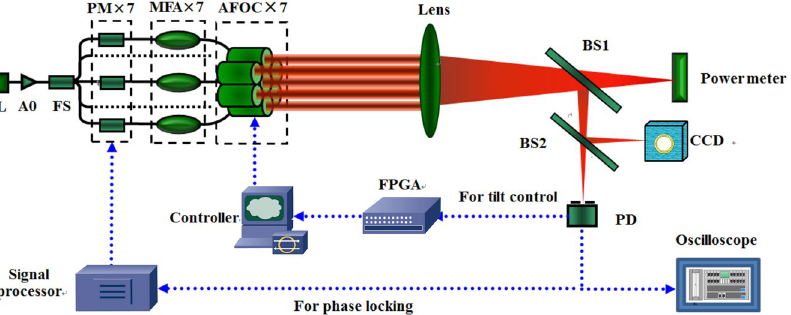
Figure 5. Experimental setup (SL: seed laser, FS: fiber splitter, PM: phase modulator, MFA: mode field adaptor, AFOC: adaptive fiber-optics collimator, BS1: 90:10 beam splitter, BS2: 50:50 beam splitter, PD: photonic